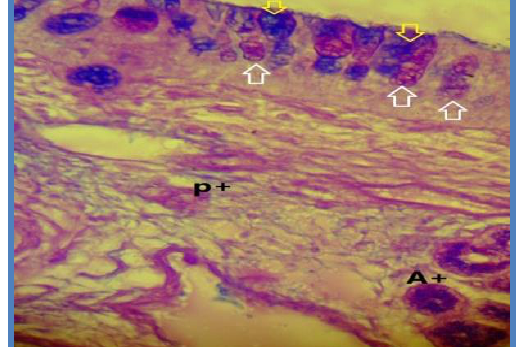
Figure (8): Histological section of nasal cavity(olfactory) showing: Se-sensoryepithelia,Bg- Bowmann gland, Nb-nerve bundles (H&EX100).